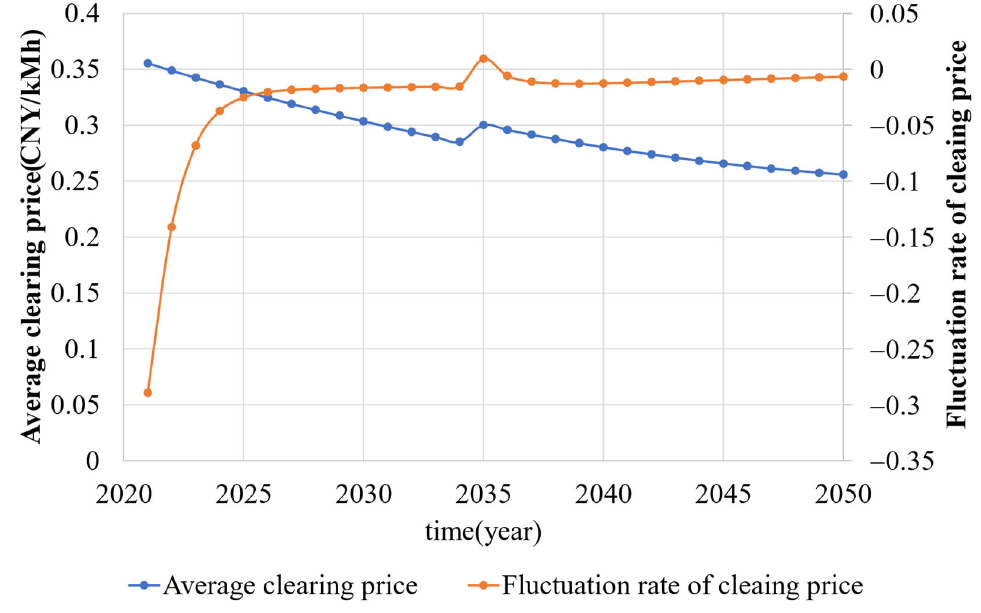
Figure 6. Trend of average clearing price under basic scenarios.